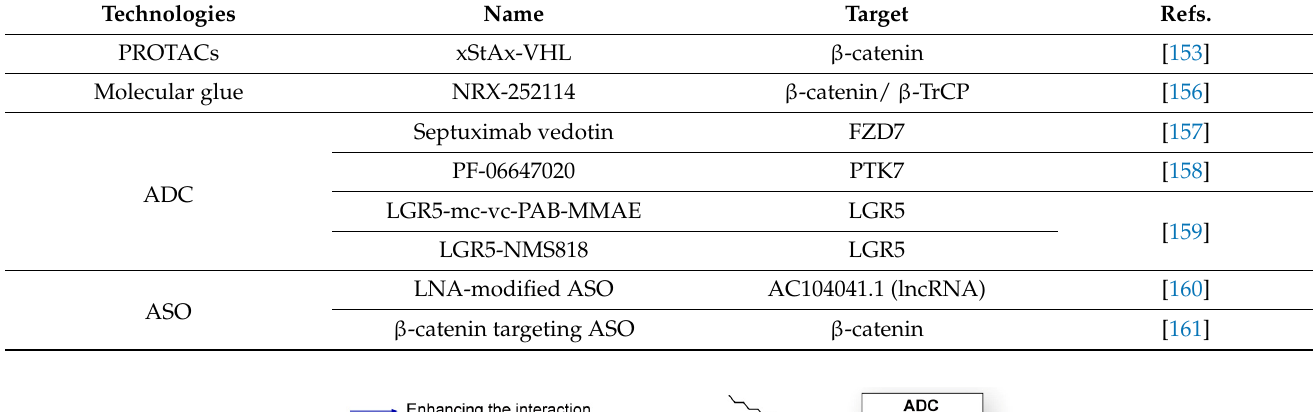
Table 3. Wnt signaling targeting agents using the latest technologies (PROTACs, ADC, and ASO).